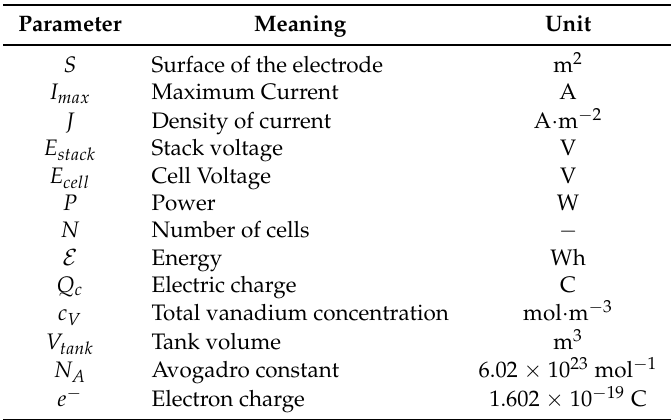
Table 3. Parameters for battery